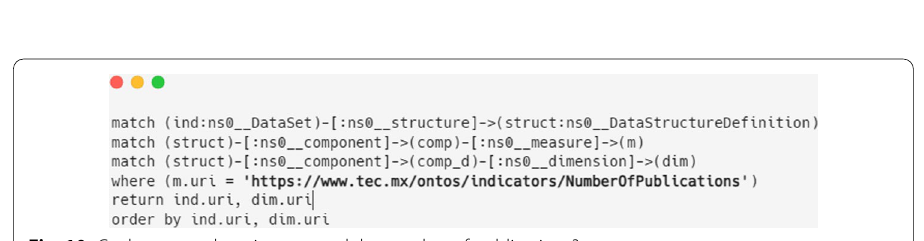
Fig. 10 Cypher query: how is measured the number of publications?